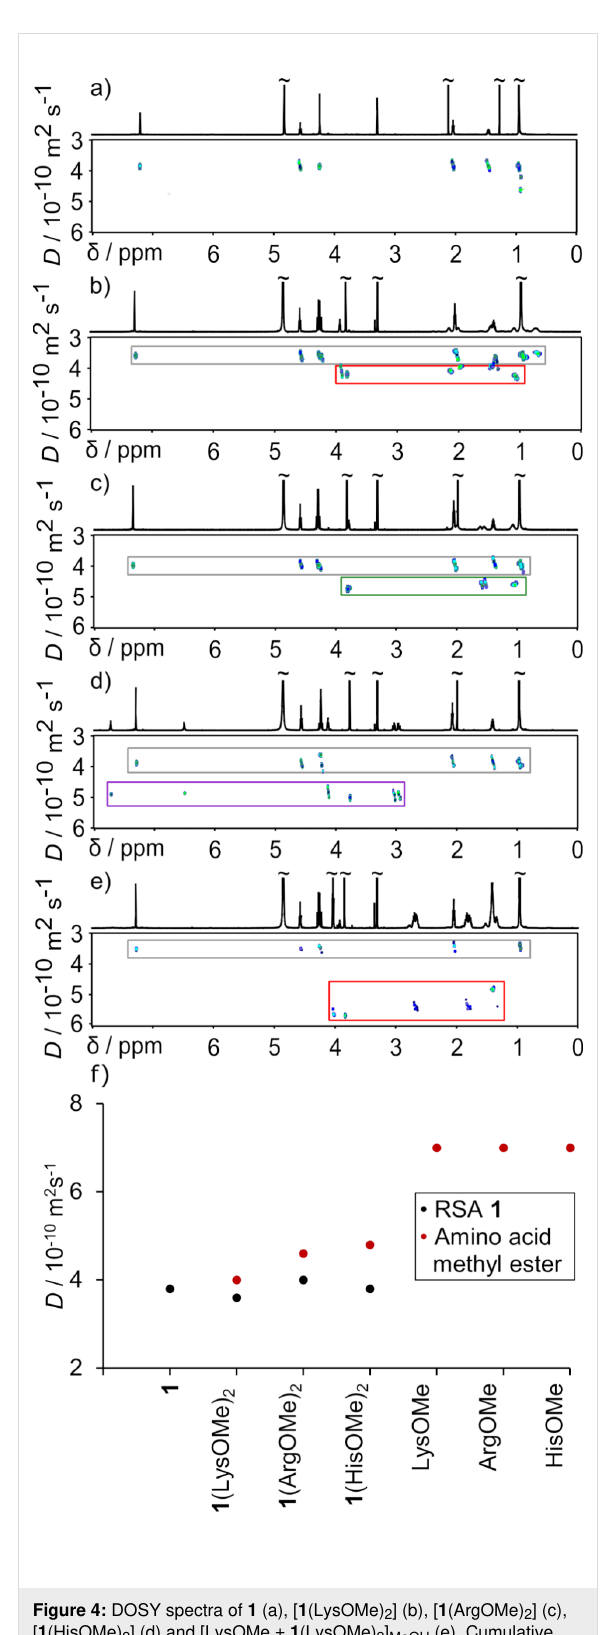
Figure 4: DOSY spectra of 1 (a), [ 1 (LysOMe) 2 ] (b), [ 1 (ArgOMe) 2 ] (c), [ 1 (HisOMe) 2 ] (d) and [LysOMe + 1 (LysOMe) 2 ] MeOH (e). Cumulative plot of diffusion coefficients (f) (methanol- d 4 , 298 K, 600